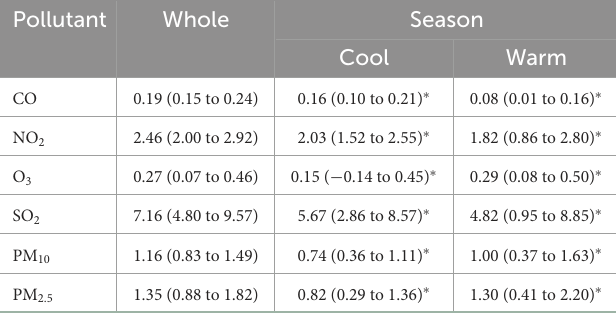
TABLE 3 Estimated ER and 95% CI of children’s outpatient visits a 10 µ g/m 3 increase in the concentrations of air pollution stratified by